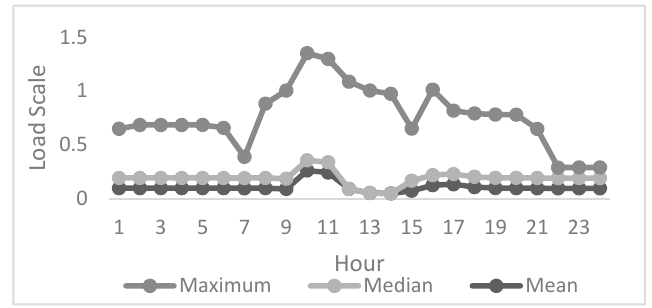
Figure 1. Office load curve [22]. Figure 1. O ffi ce load curve